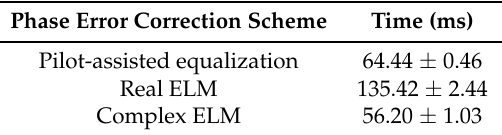
Table 2. Complexity